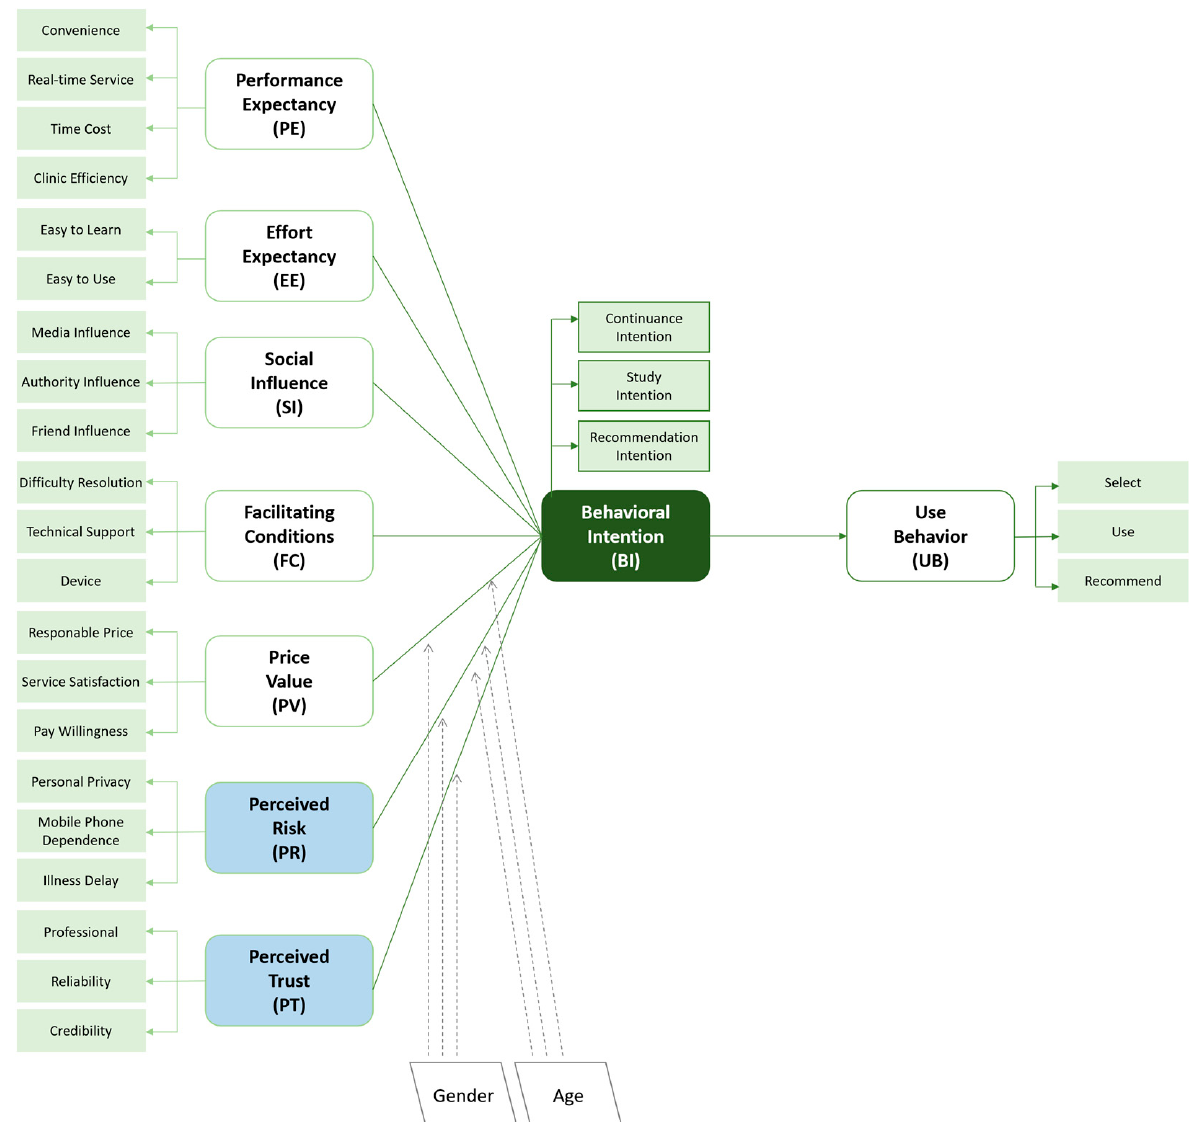
Figure 1. The adjusted UTAUT-2 model based on the interviews.